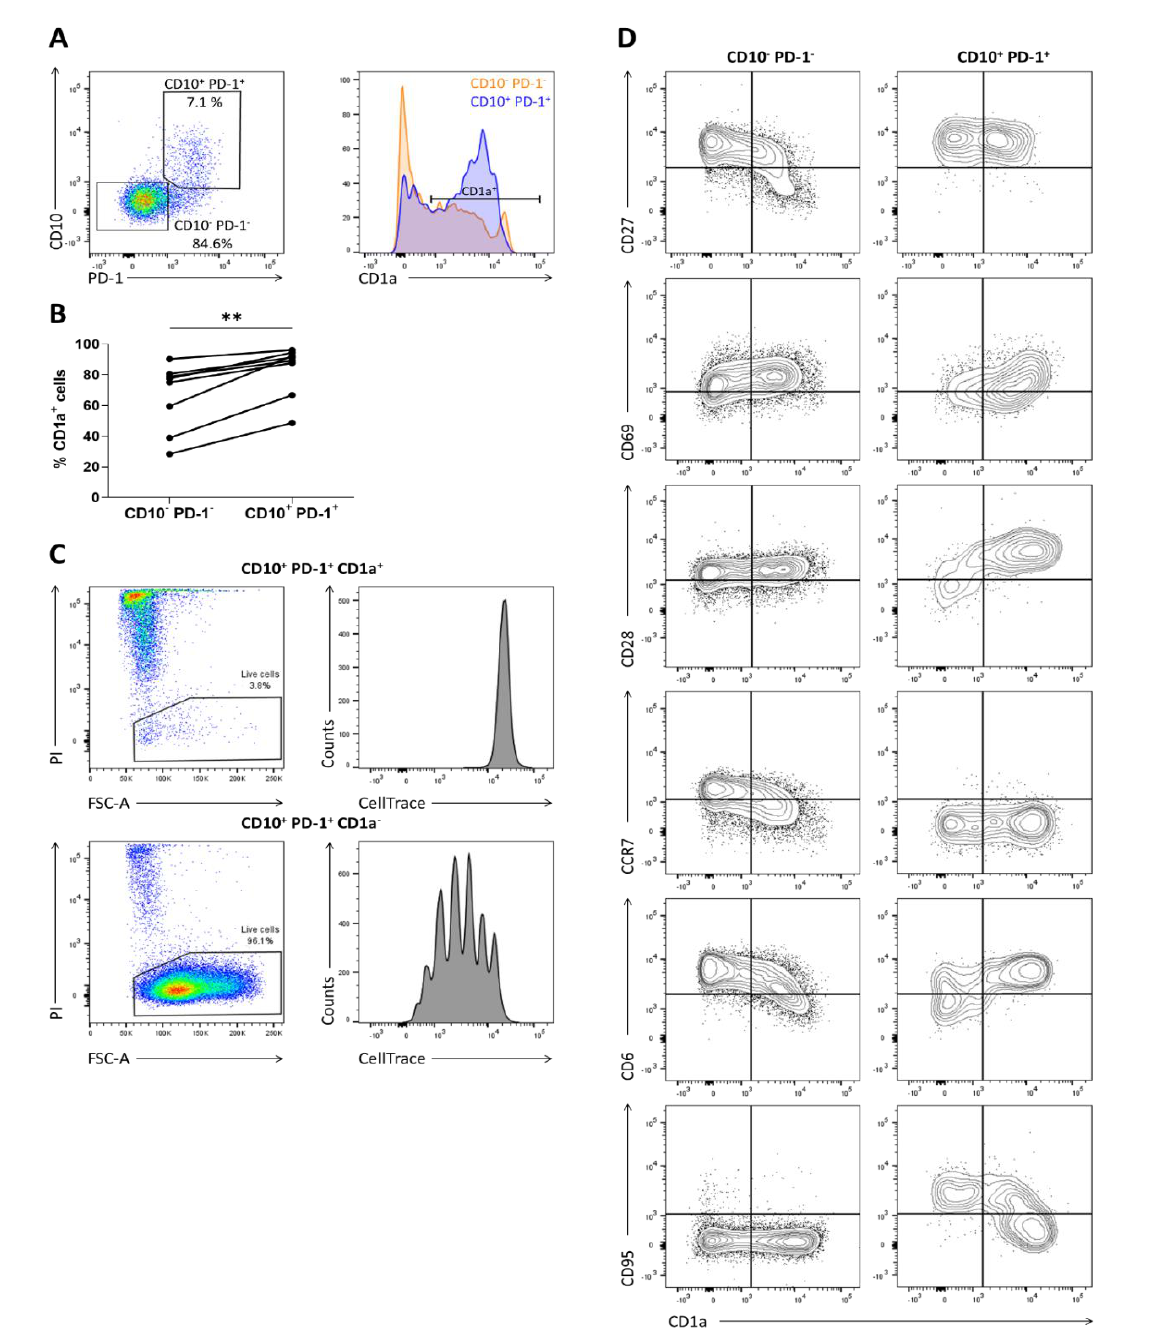
Figure 1. CD1a marks the immature CD10 + PD-1 + cells incapable of proliferating in the presence of IL-15. ( A ) CD1a expression on CD10 − PD-1 − and CD10 + PD-1 + T cells in human postnatal thymus, gated on TCR γδ – CD3 +/ low CD4 – CD8 α + ; ( B ) percentage of CD1a + cells in each population in 8 postnatal thymuses. Connected values correspond to paired populations of the same biological replicate. Wilcoxon matched-pairs signed-rank test was used to assess the statistically significant di ff erence in CD1a expression between the CD10 − PD-1 − and CD10 + PD-1 + population. p -value < 0.01 (**); ( C ) proliferation and viability assessed by CellTrace Violet dye dilution and propidium iodide (PI) exclusion in CD10 + PD-1 + CD1a + and CD10 + PD-1 + CD1a − cells isolated from human postnatal thymus after 5 days of incubation in the presence of IL-15 (10 ng / mL). Data are representative of at least three biological replicates; ( D) flow cytometric analysis of phenotypic di ff erentiation during maturation of the thymic CD10 + PD-1 + and CD10 − PD-1 – population. Data are representative of at least two biological replicates.